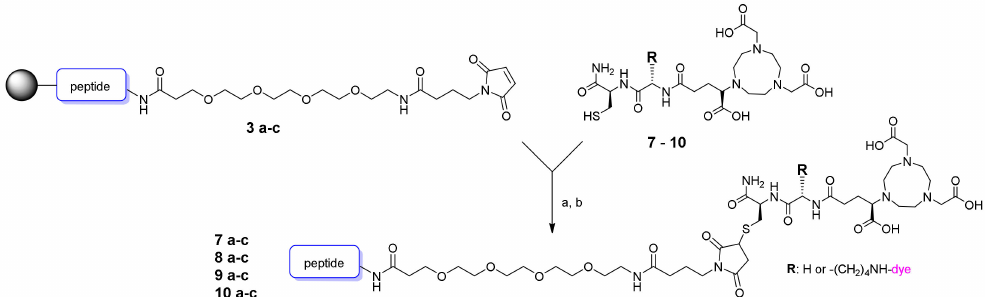
Scheme 3. Schematic depiction of the conjugation reaction of the maleimide-modified peptides 3 a-c with the corresponding MIUs 7 - 10 to the hybrid peptide-MIU-conjugates 7 a-c , 8 a-c , 9 a-c and 10 a-c . Reaction conditions: (a) conjugation of the building blocks: H 2 O/CH 3 CN (1/1, v/v ), 5 min, pH = 7; (b) cleavage from resin: TFA/TIS (95/5, v/v ), 1 h.